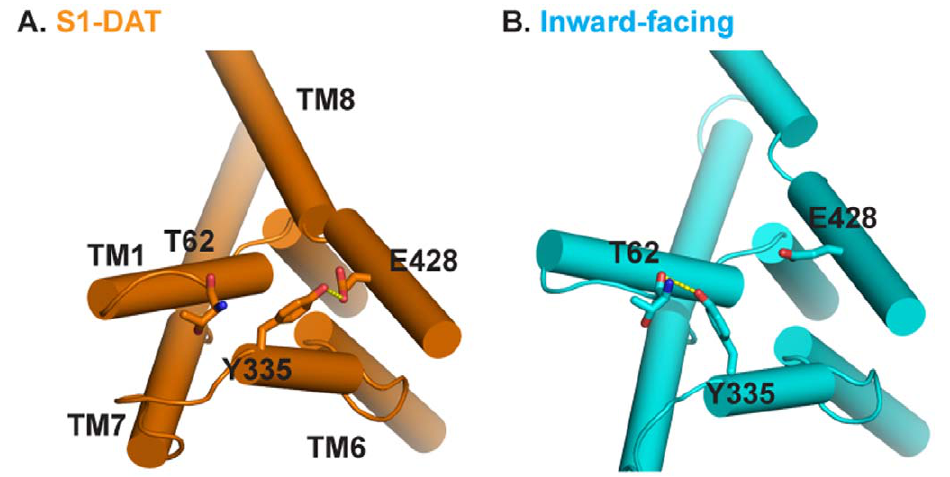
Figure 6. Changes in intracellular interaction networks. Y335 6.68 forms an H-bond with E428 8.66 in S1-DAT ( A ), and switches its H-bond partner to T62 1.27(NT) in the inward-facing conformation ( B ). doi:10.1371/journal.pone.0016350.g006 PLoS ONE |